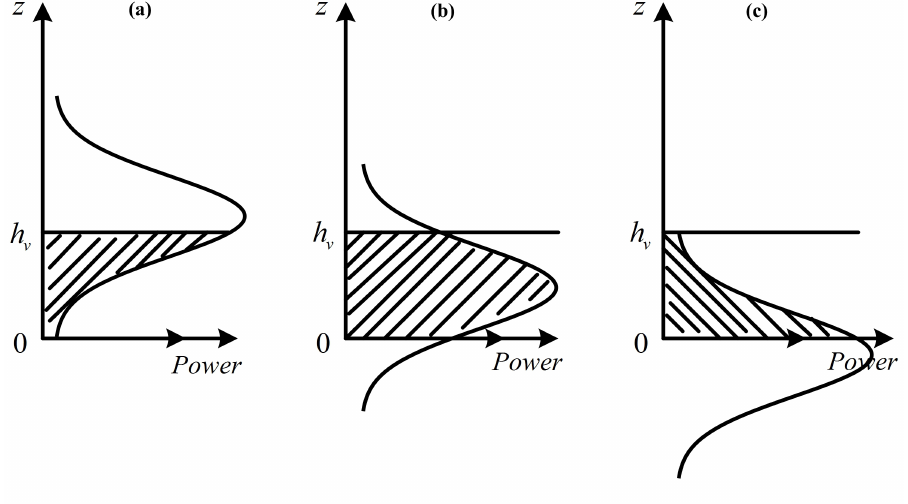
Figure 2. The profile of Gaussian vertical backscatter volume over ground. ( a ): δ ≥ h v ; ( b ): δ ∈ ( 0, h v ) ; ( c ): δ ≤